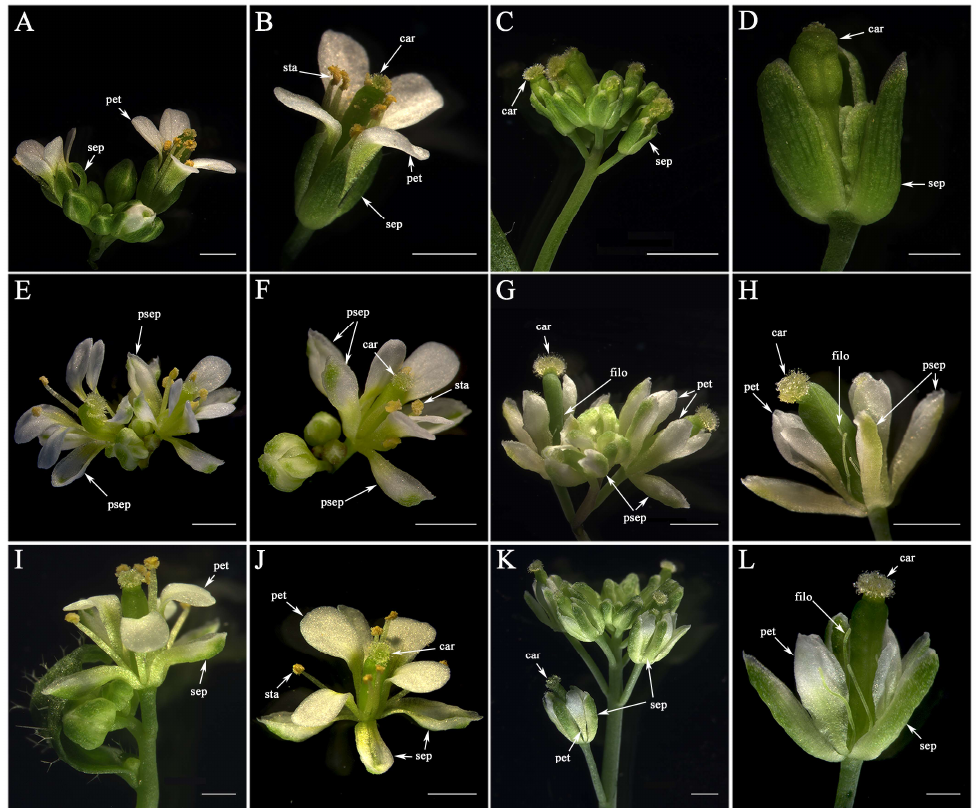
Figure 5. Phenotypes comparison of the wild-type, homozygous pi-1 mutant, 35S:: CyfaPI transgenic Arabidopsis under a wild-type and homozygous pi-1 mutant background. ( A ) Inflorescence of wild-type Arabidopsis ; ( B ) Wild-type Arabidopsis flower with normal 4 concentric whorls of floral organs (4 sepals in whorl 1, 4 petals in whorl 2, 6 stamens in whorl 3 and a gynoecium in whorl 4); ( C ) Inflorescence of homozygous pi-1 mutant Arabidopsis ; ( D ) Flower of homozygous pi-1 mutant Arabidopsis with two outer whorl sepals and one inner whorl gynoecium; ( E ) Inflorescence of 35S:: CyfaPI transgenic Arabidopsis in wild-type background displaying severe phenotype changes; ( F ) Flower of 35S:: CyfaPI transgenic Arabidopsis in wild-type background showing severe phenotype changes; ( G ) Inflorescence of 35S:: CyfaPI homozygous pi-1 transgenic Arabidopsis showing strong complementation phenotypes; ( H ) Flower of 35S:: CyfaPI homozygous pi-1 transgenic Arabidopsis showing strong complementation